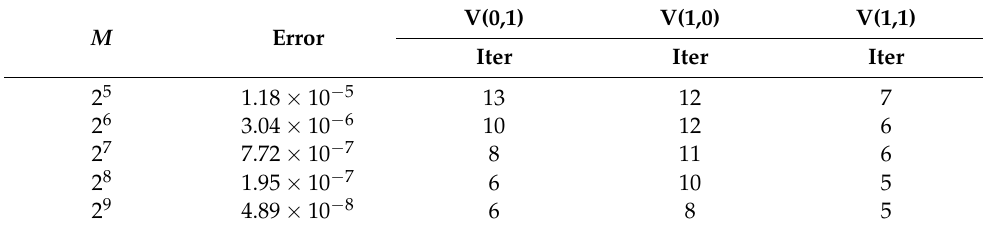
Table 2. L 2 errors for (72) with ω = 0.5 by the second-order scheme.